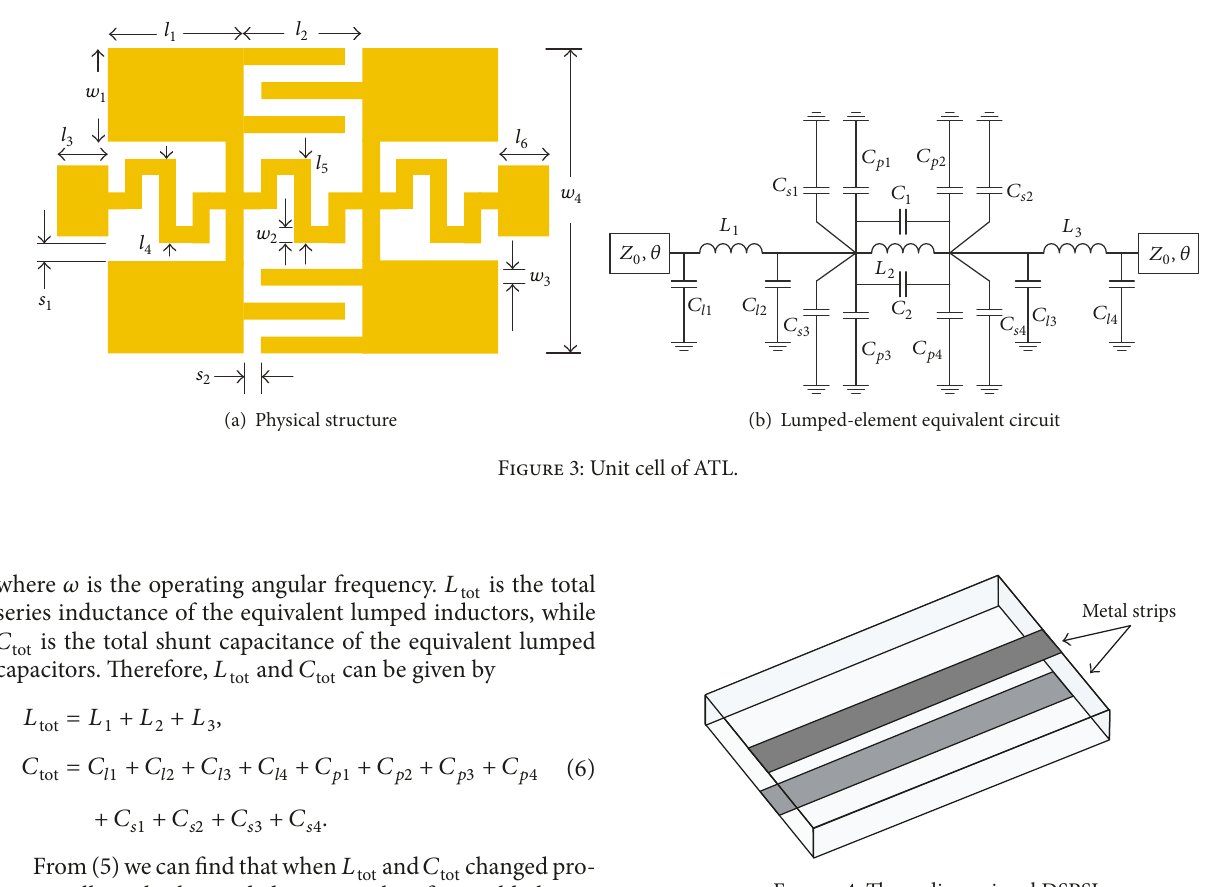
Figure 4: Three-dimensional